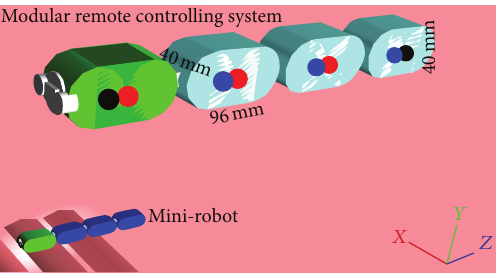
Figure 1: The modular remote controlling system (MCS) is identical to the modular miniature robot but in large scale, thus four times larger.